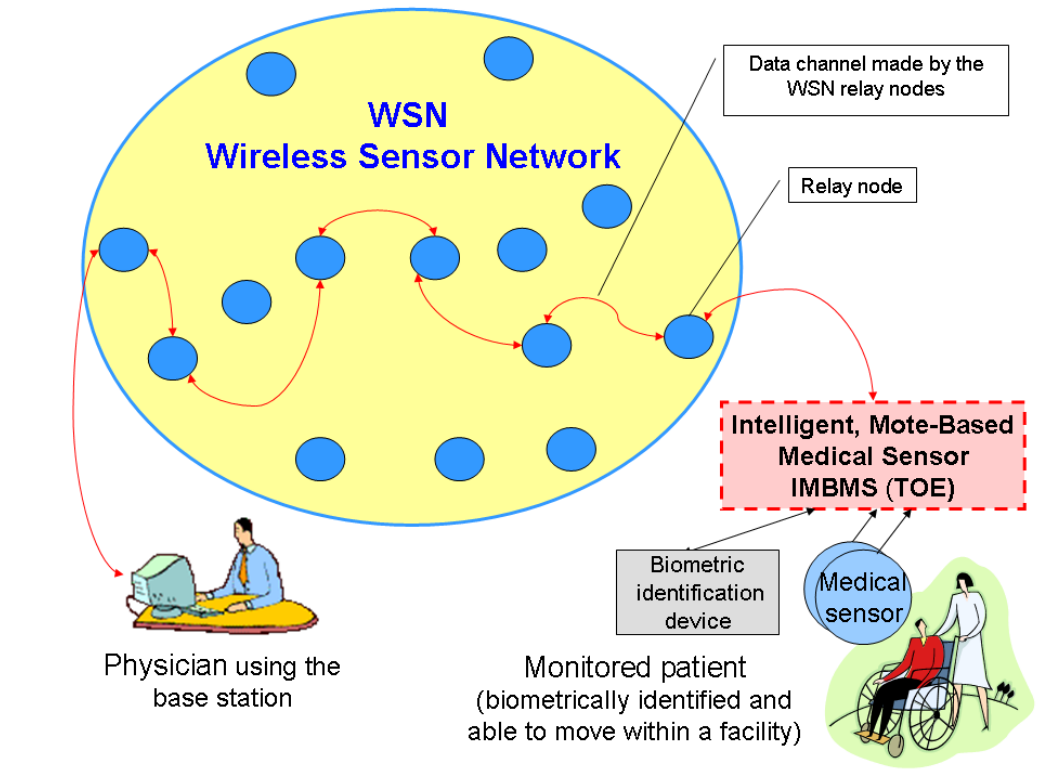
Figure 2. General architecture of the ―Secure Wireless Mote-Based Medical Sensor Networ k‖